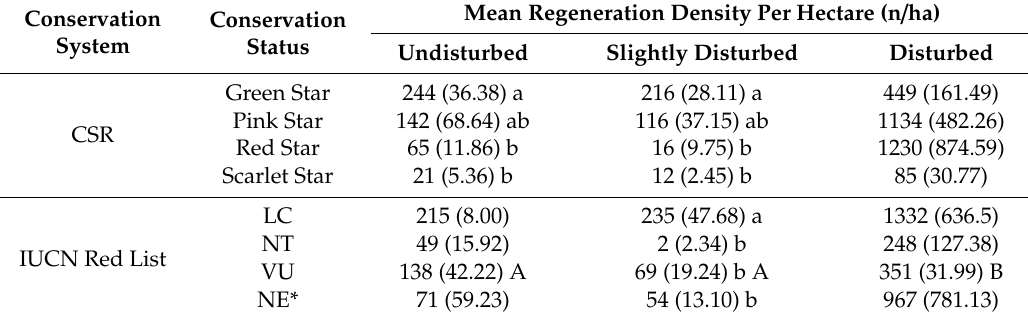
Table 4. Multiple comparison tests of the conservation status of tree species in gap regeneration under three di ff erent forest areas from a regional Conservation Star Ratings (CSR) and global International Union for Conservation of Nature (IUCN) Red List of Threatened Species ™ perspectives. Mean values with corresponding standard errors in parentheses are